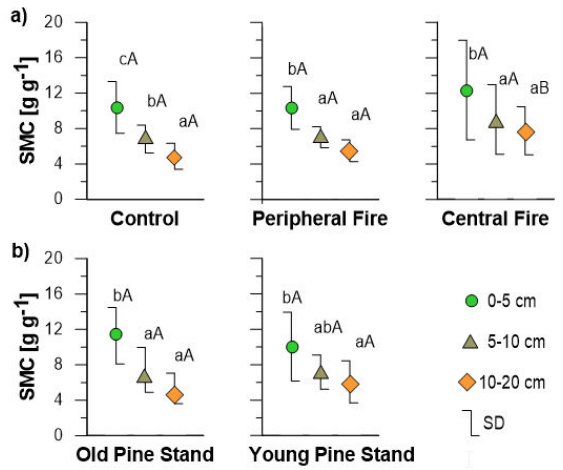
Figure 2. The average value of SMC—soil moisture content and SD—standard deviation for three soil depths: 0–5 cm, 5–10 cm and 10–20 cm, ( a ) on sites with di ff erent strengths of fire (i.e., control,